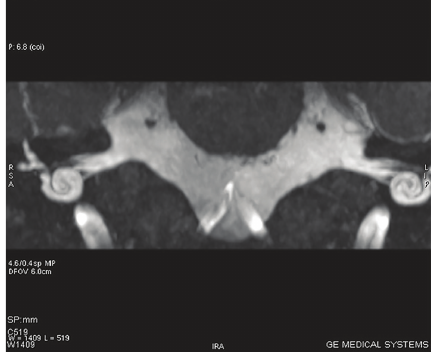
Figure 2: MRI scan of inner ear with axial section showing cochlear anomaly in which cochlea shows 1 and 1 / 2 turns.